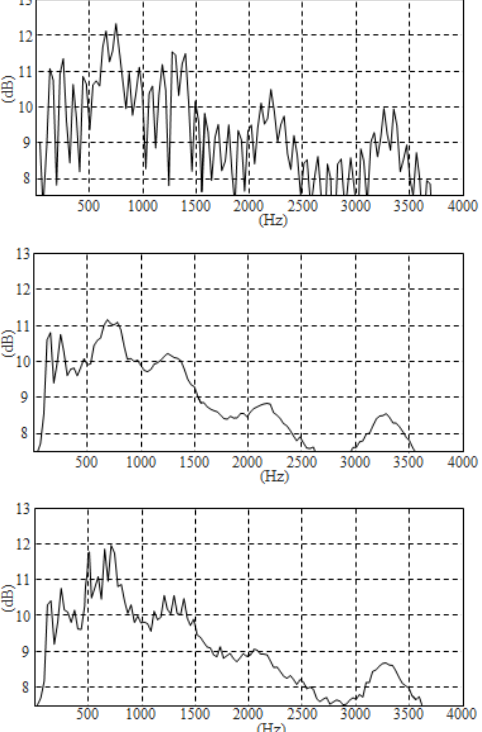
Figure 7. Example of spectra. ( Top ): Original speech. ( Middle ): Predicted using baseline method ( w s = 0, N k = 0). ( Bottom ): Predicted using PD and He ( w s = 0.25, N k =